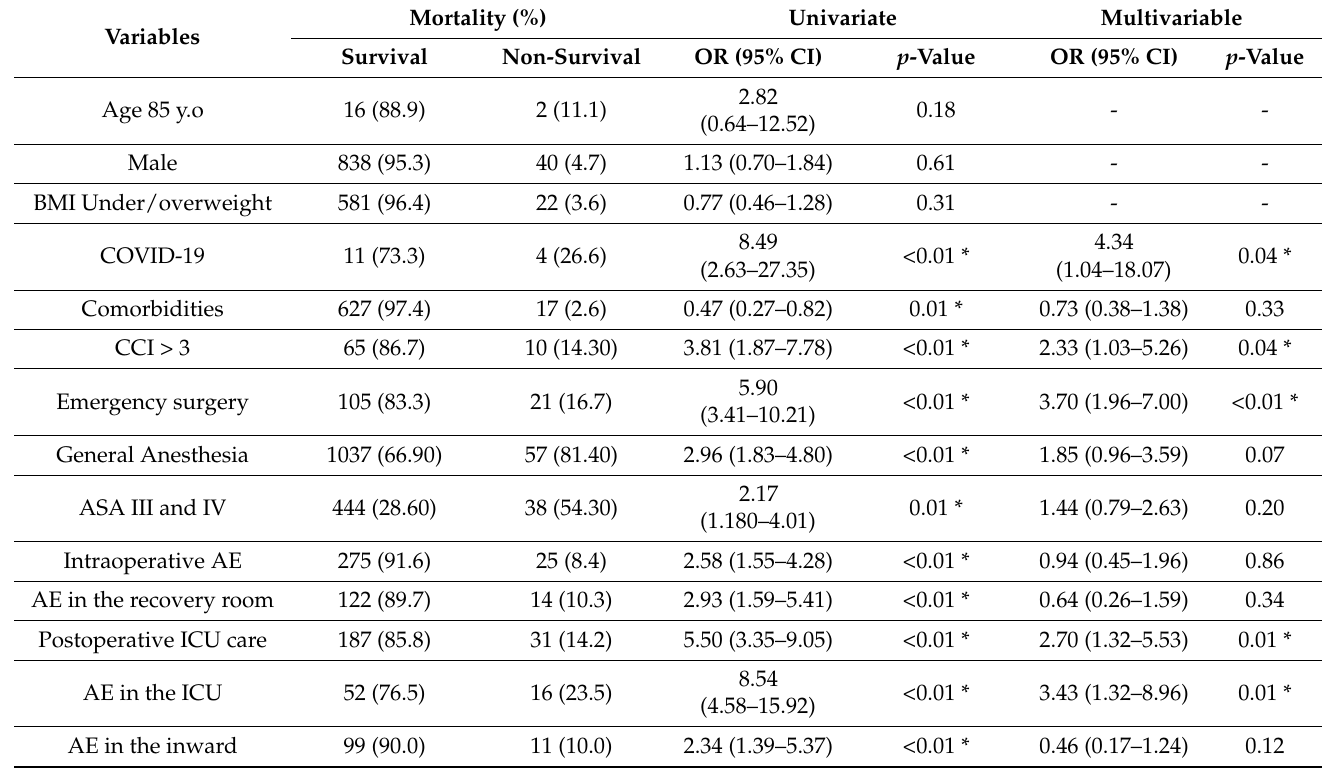
Table 3. Univariate and multivariable logistic regression analysis for patient characteristics with mortality of geriatric patients undergoing surgery.